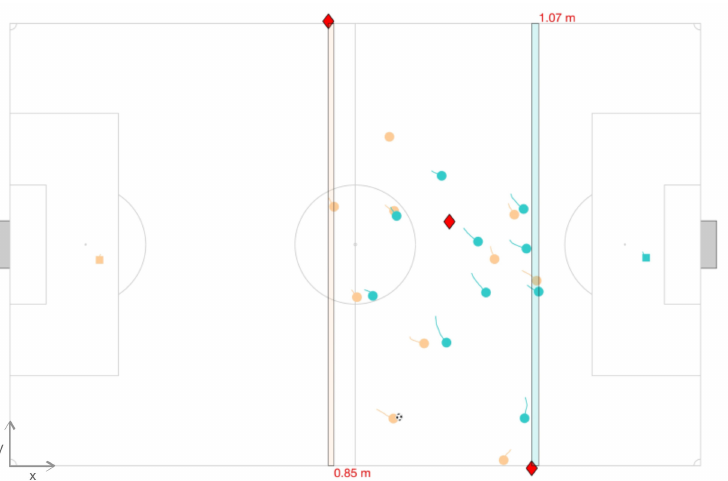
Figure 1. Match frame animation. The referee and the assistant referees are plotted as red diamonds. The distance depicts the alignment of the assistant referee with the 2nd last defender. For example, the assistant referee on the right is 1.07 m misaligned with the 2nd last defender (offside line).